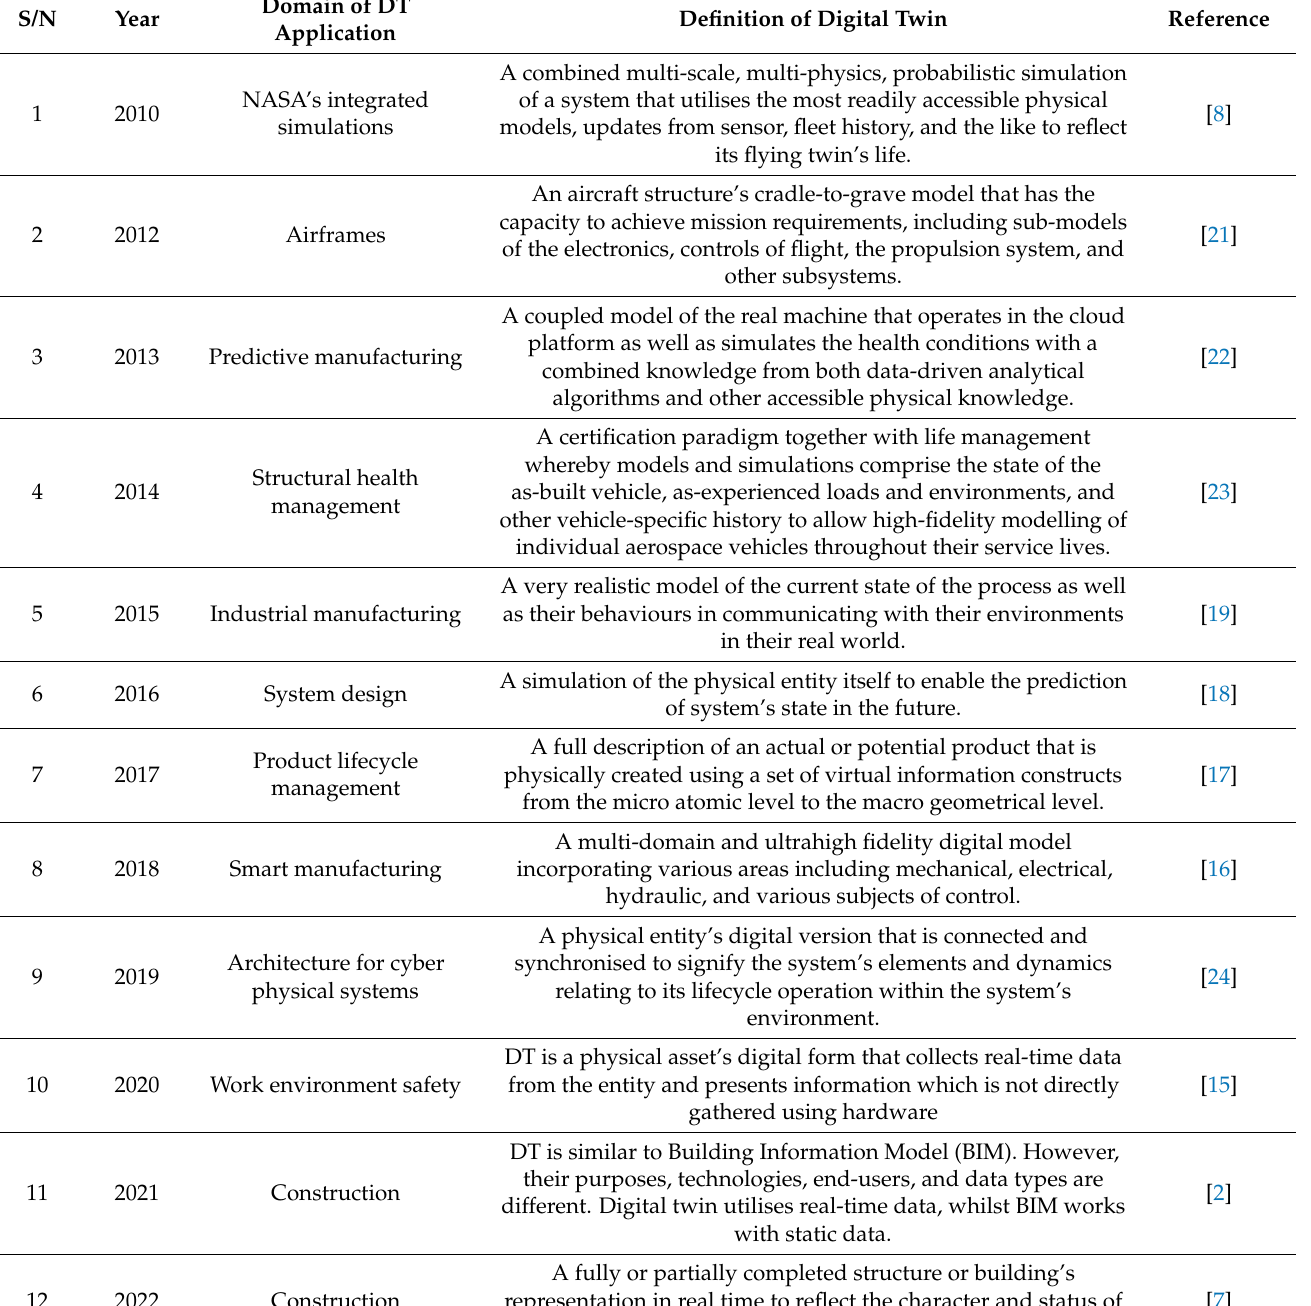
Table 1. Sample list of yearly DT definitions in the